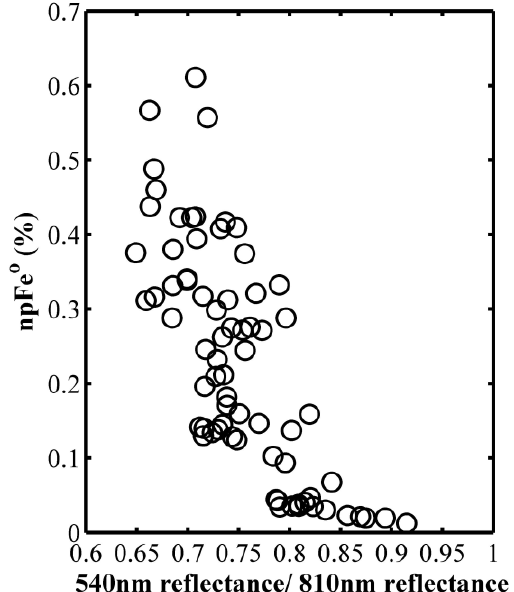
Figure 6. Correlation between the ratio of 540 nm reflectance/810 nm reflectance and npFe 0 for all size groups of LSCC soil samples.